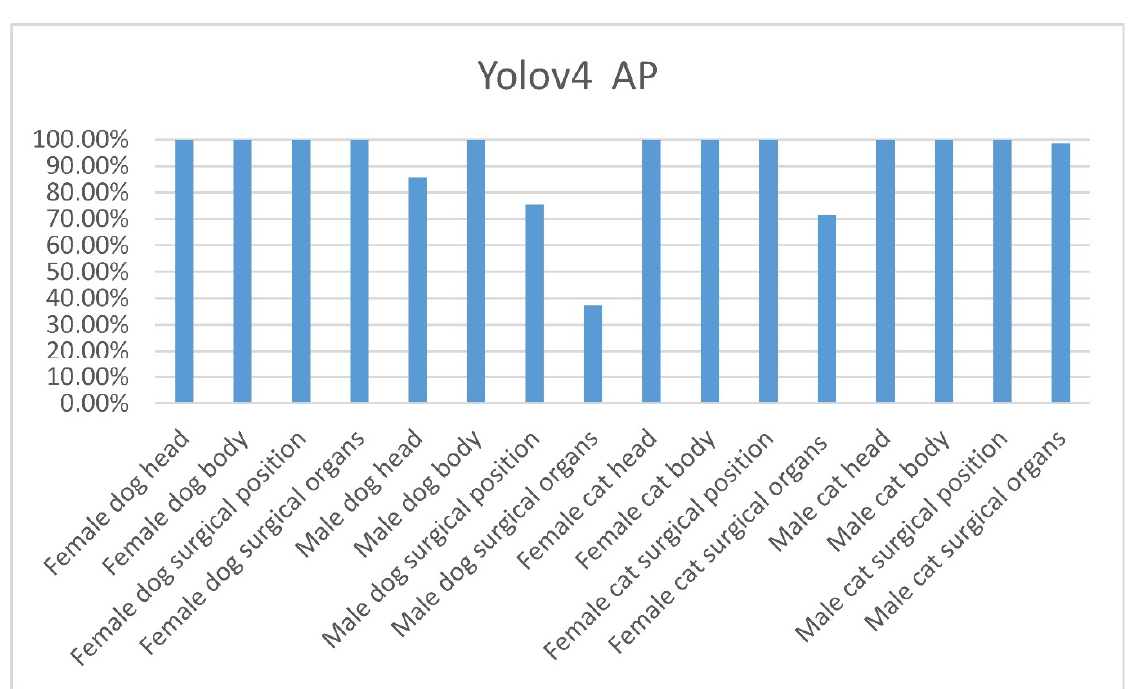
Figure 17. Yolov4 AP of each category under the balanced data set. Table 17. The performance of Yolov4 majority voting on multi-classification under the balanced dataset.